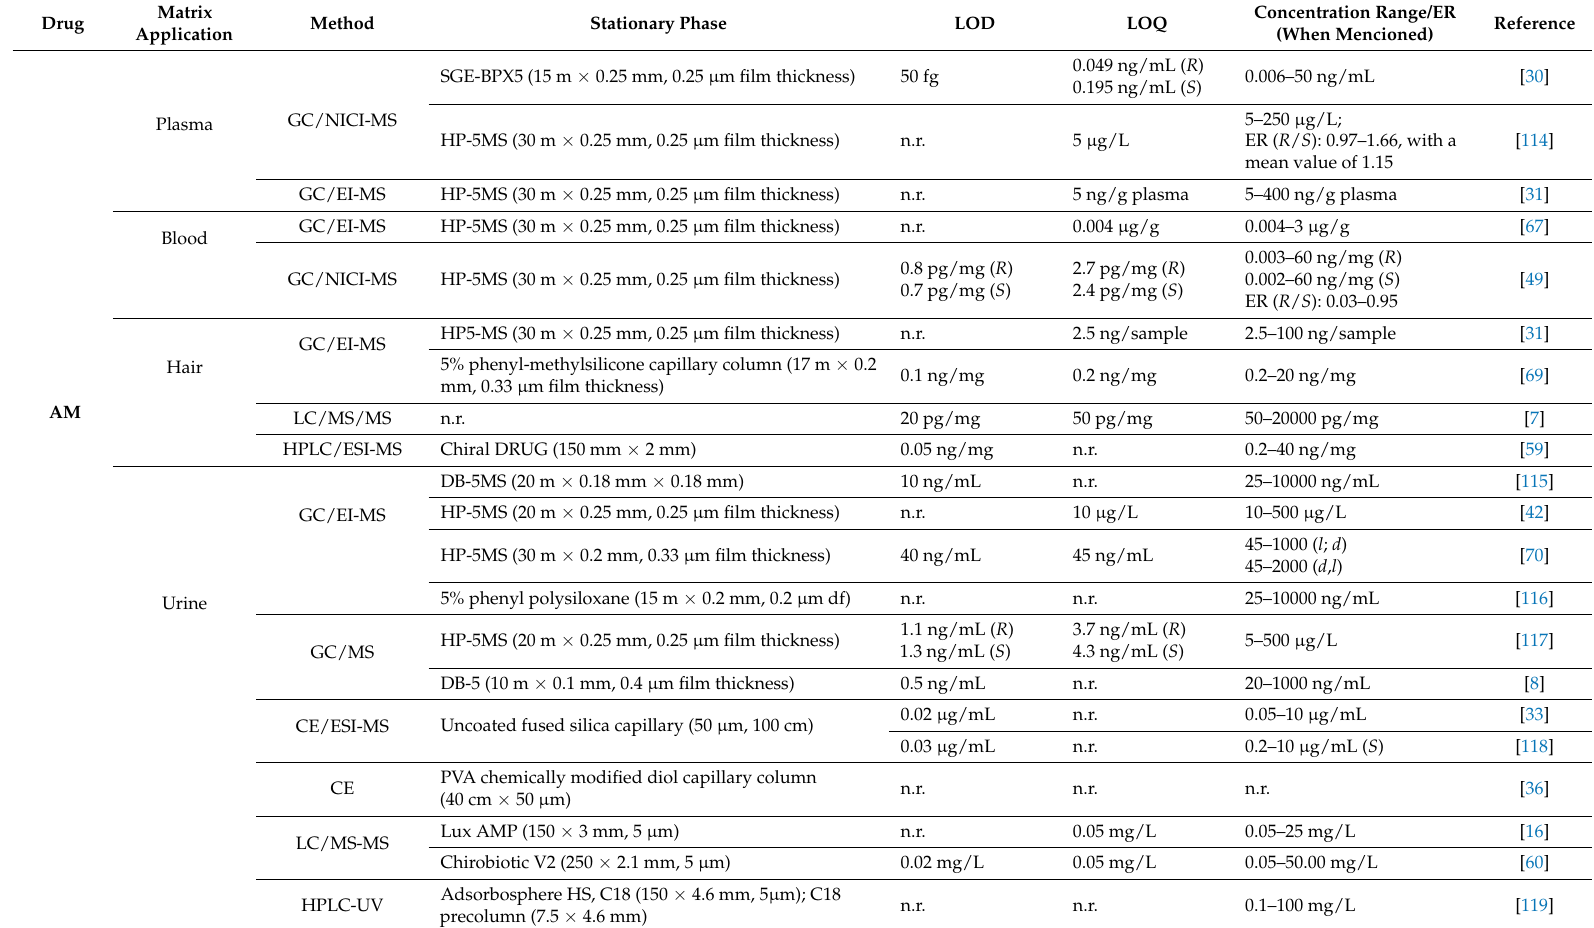
Table 2. Chromatographic analytical methods described for the analysis of chiral illicit drugs and pharmaceuticals in biological matrices.